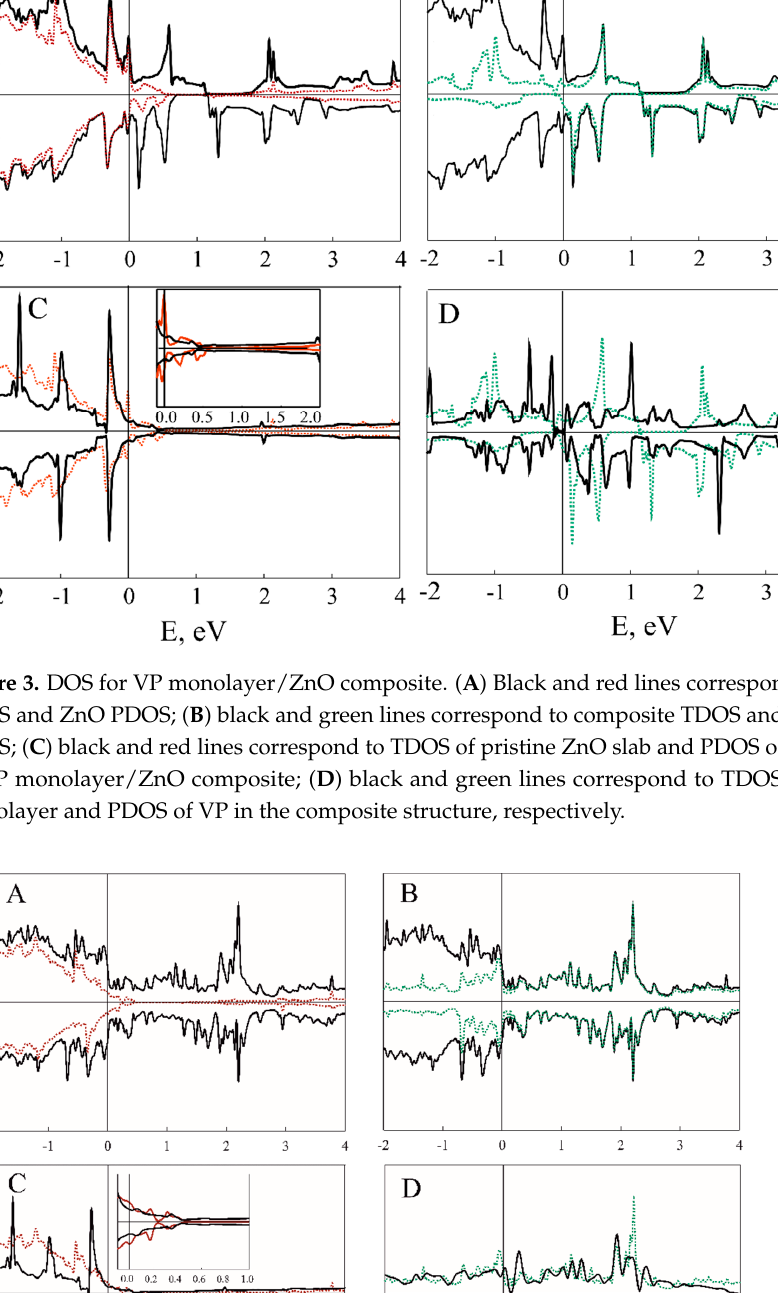
Figure 5. DOS for V 4 P 4 /ZnO composite. Black, red ( A ), green ( B ), blue ( C ) and brown ( D ) lines corresponds to composite TDOS and Zn, O, V and P atoms PDOS, respectively.